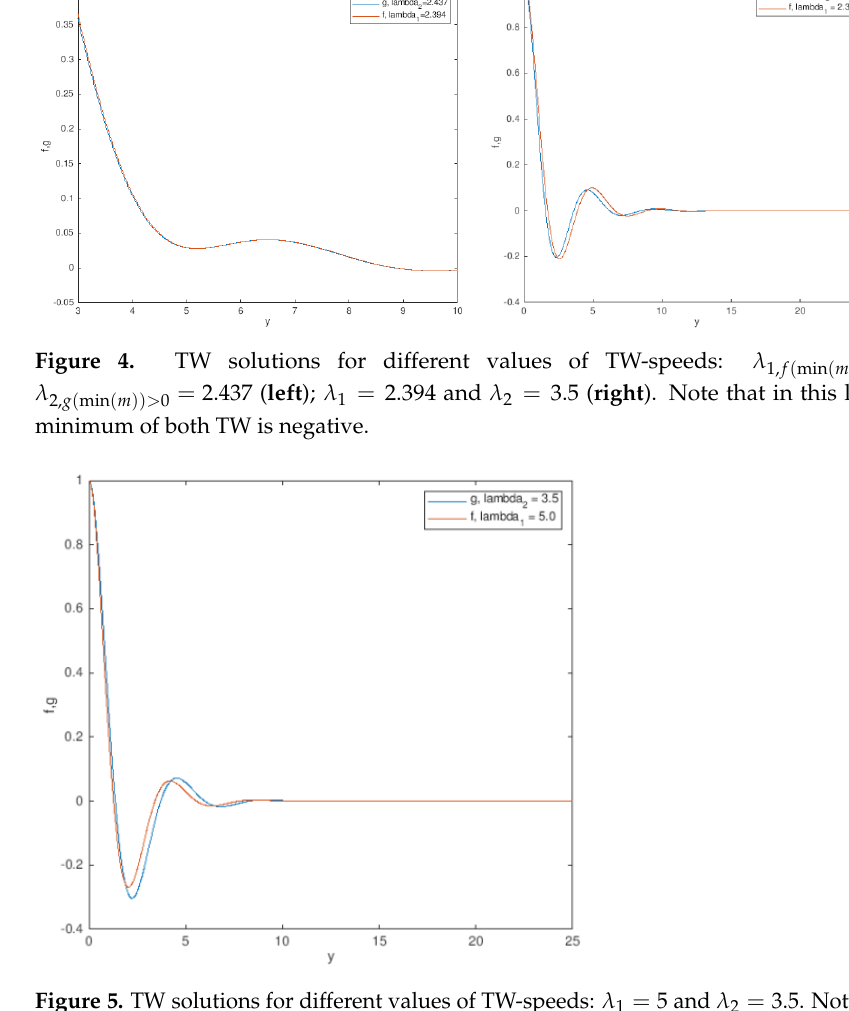
Figure 5. TW solutions for different values of TW-speeds: λ 1 = 5 and λ 2 = 3.5. Note that in this case the first minimum of both TW is